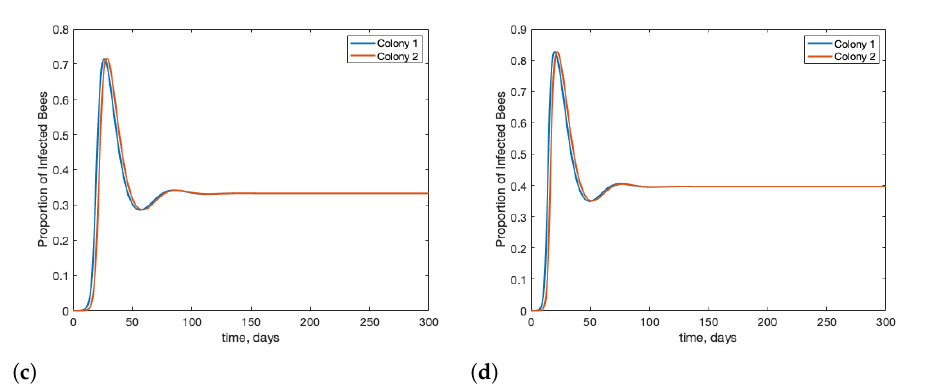
Figure 5. Beginning from equilibrium, we introduce one infected forager into colony 1 ( 1 F I ( 0 ) = 1). Subfigure ( a ) shows the impact of only forager drift on the system of two colonies; ˆ d 12 = ˆ d 21 = ˆ r 1 = ˆ r 2 = 0 and all other parameters as in Table 1. Subfigure ( b ) shows the impact of only drone drift; d 12 = d 21 = r 1 = r 2 = 0 and all other parameters as in Table 1. Comparing panels ( c , d ), we see that forager drift is mainly responsible for alleviating infection pressure in the colony as when forager drift is removed, the situation in colony 1 is very similar to when there is no drift at all.